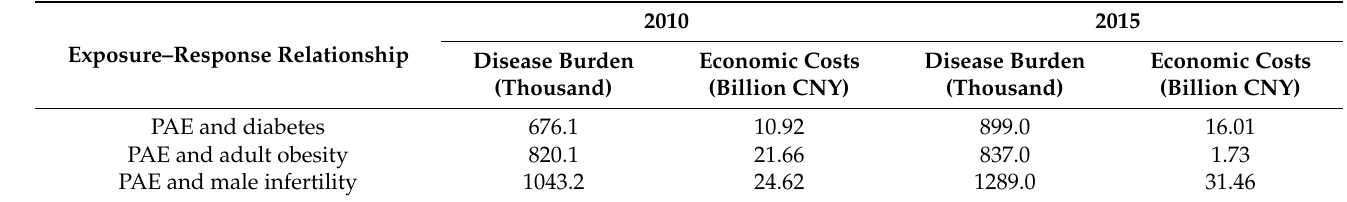
Table 3. Comparison of attributable disease burdens in the general Chinese population in 2010 and